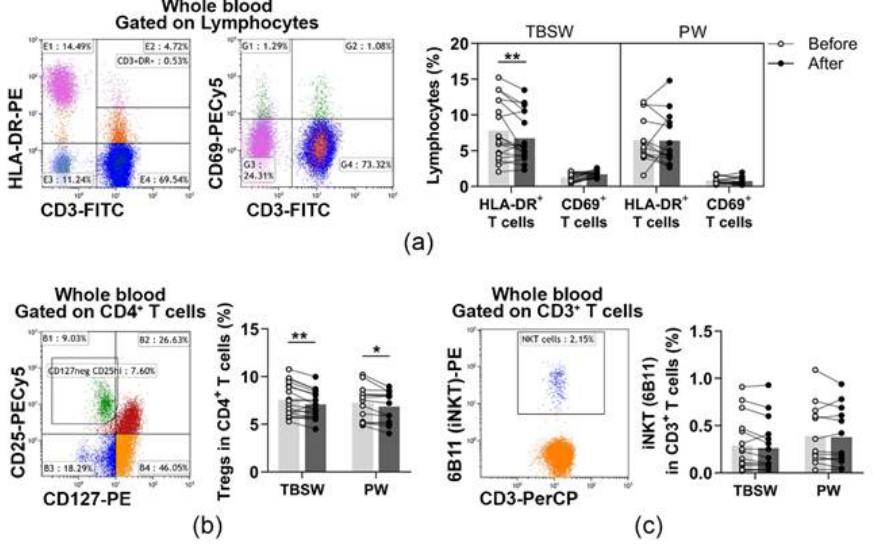
Figure 3. Measurement of lymphocytes with a regulatory function in young women after a 14-week exercise program. The whole blood of 32 healthy volunteers was stained with labelled monoclonal antibodies, as described previously. According to the exercise courses, the trainees were divided into total-body-shaping workout (TBSW, n = 18) and Pilates workout (PW, n = 14) subgroups. ( a ) Representative dot plots demonstrate the identification of CD3 + HLA-DR + late-activated and CD3 + CD69 + early activated T cells. The bar chart indicates the frequencies of activated T cells. ( b ) Representative dot plot indicates the identification of CD4 + CD25 bright CD127 lo/ − Treg cells within CD4 + T cells. The bar chart indicates the ratio of Treg cells. ( c ) Representative dot plot shows the determination, and the bar chart indicates the frequencies of CD3 + 6B11 + NKT cells. 6B11 is referred to as the invariant NKT (iNKT) marker. Repeated measures two-way ANOVA with Bonferroni correction for multiple comparisons was used for activated T cells, and paired T-test or Wilcoxon test was used for the statistical analysis of NKT and Treg cells. Each data point represents an individual subject, while bars show the mean values. Statistically significant differences are indicated by * p < 0.05; ** p <